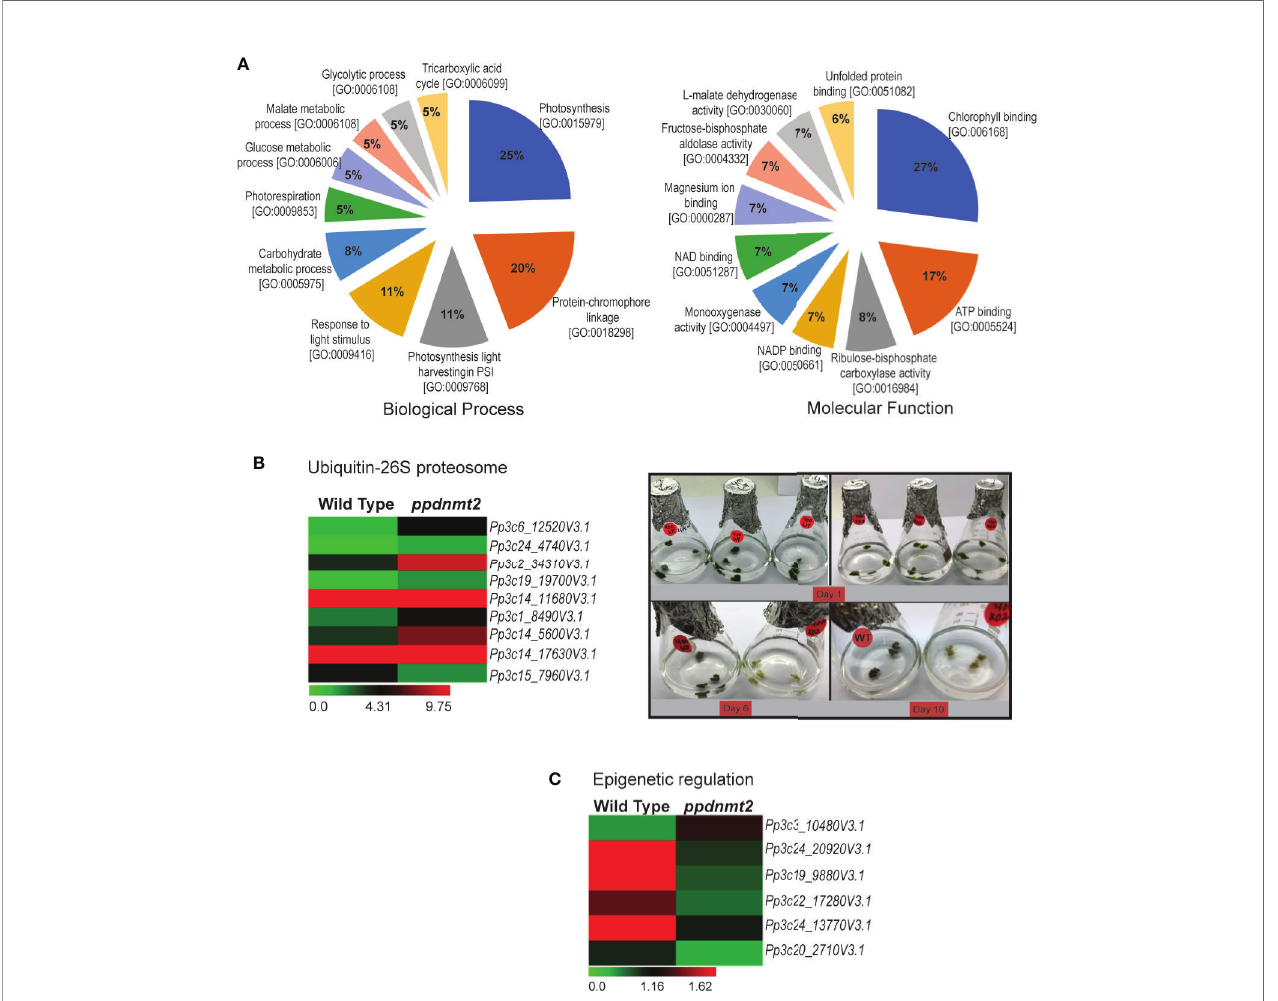
FIGURE 8 | (A) Pie charts depicting top 10 Biological Process and Molecular Function Gene Ontology categories to which P-signi fi cant (p value <= 0.05) proteins co-immunoprecipitated with PpDNMT2 can be classi fi ed. (B) Left: Differential expression pattern of genes involved in Ubiquitin-26S proteasome in wild type and ppdnmt2 presented by cluster display with color scale representing FPKM expression values; Right: Wild type (WT) and ppdnmt2 (KO#2) protonemata propagated in BCDAT media supplemented with 400 mM NaCl under similar growth conditions for 10 days to analyze stress tolerance of plants lacking PpDNMT2 function. (C) Differential expression of genes in wild type and ppdnmt2 involved in epigenetic regulation displayed in the form of a heat map with color scale representing range of FPKM values of the